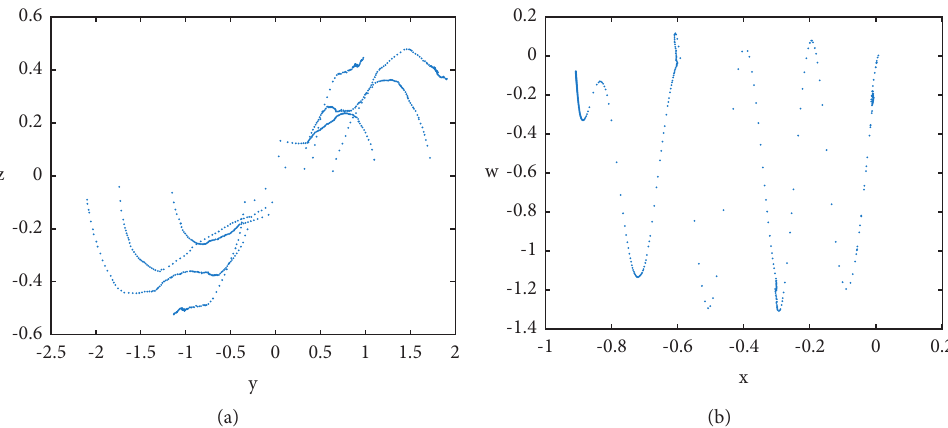
Figure 6: Poincar`e diagram of the system. (a) Section w � 0 in the yzw phase diagram. (b) Section z � 0 in the xzw phase diagram.